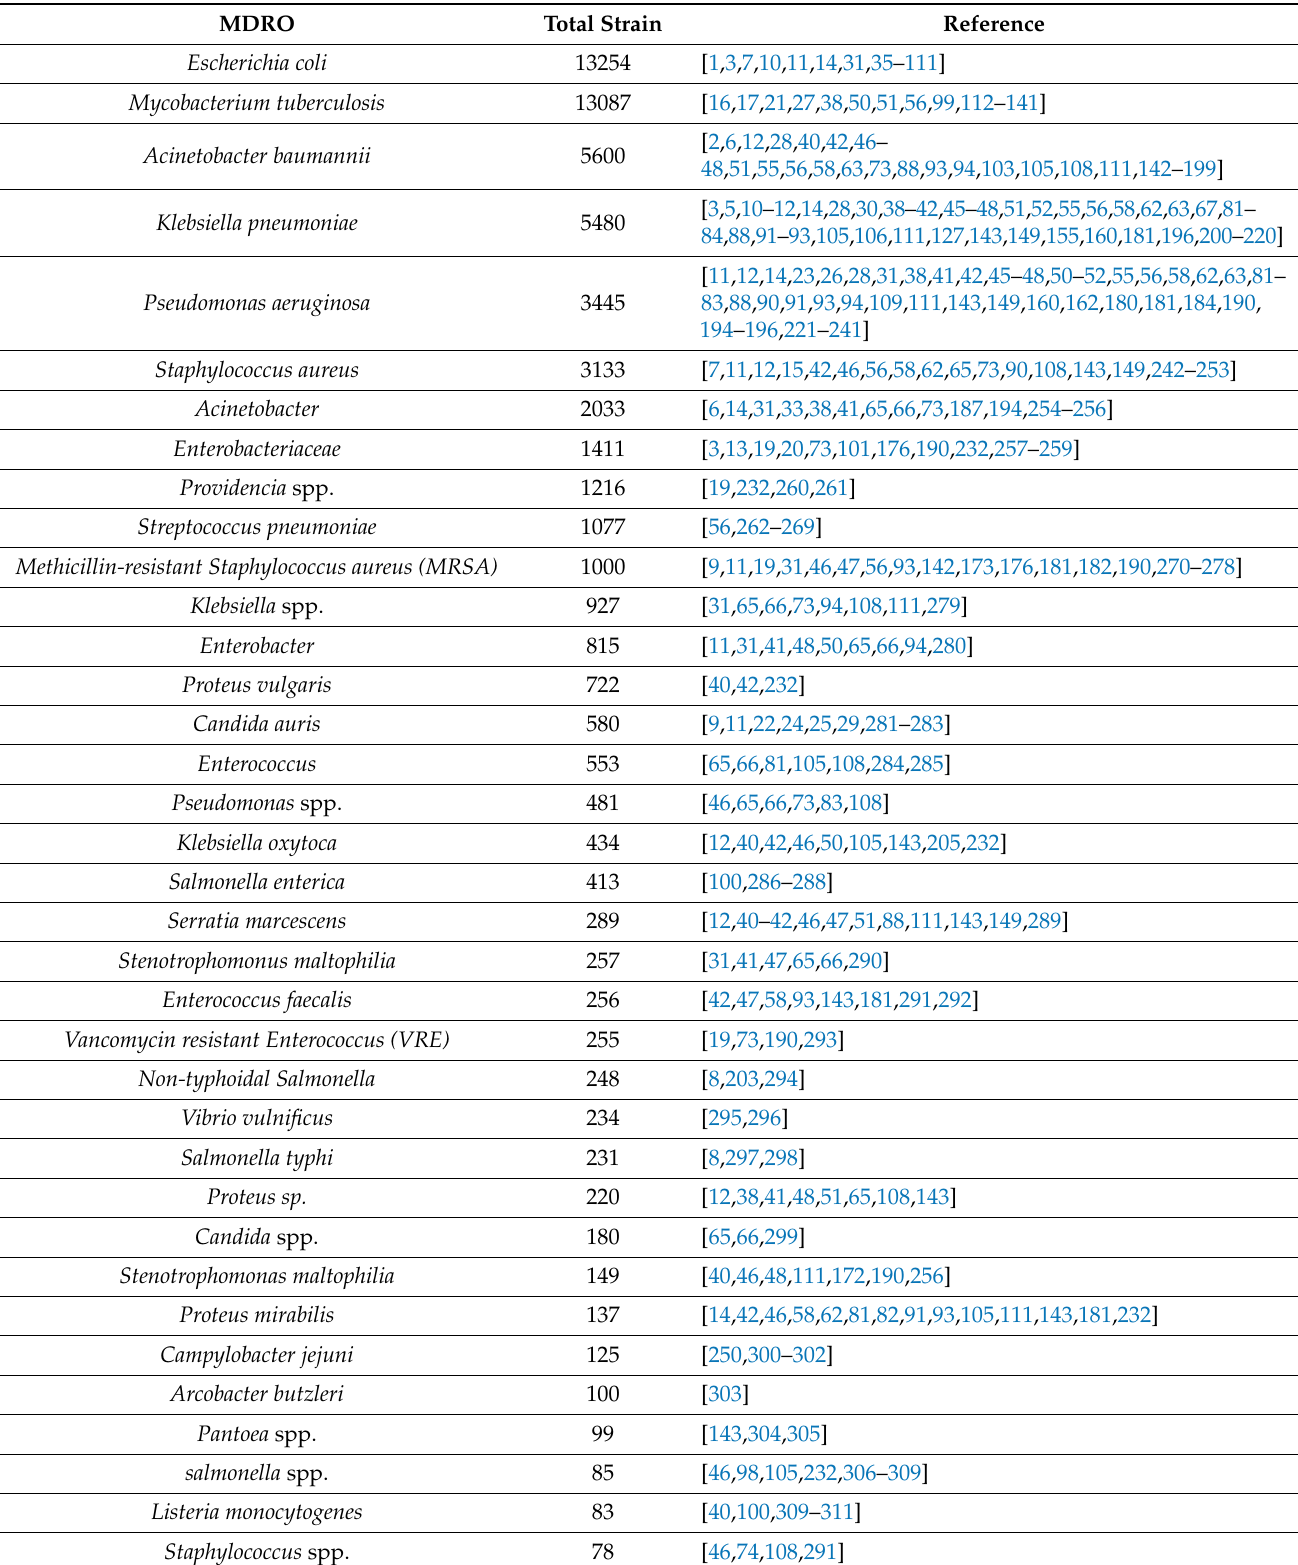
Table 5. Number of multi drug-resistant strains reported in the Arabian Peninsula. Details of the number of strains are presented in the Supplementary Table